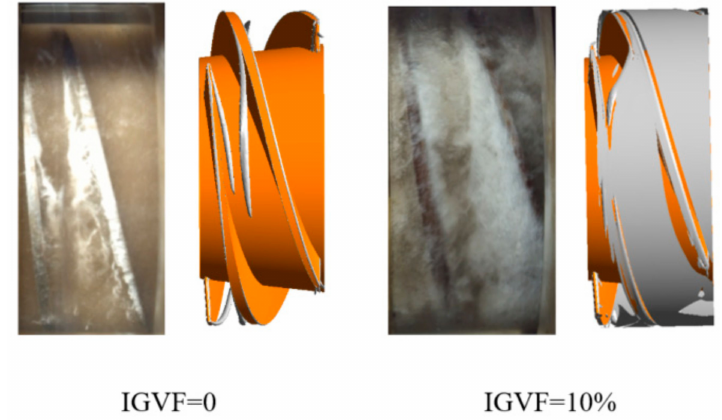
Figure 7. Comparison of the experimental flow field and simulated flow